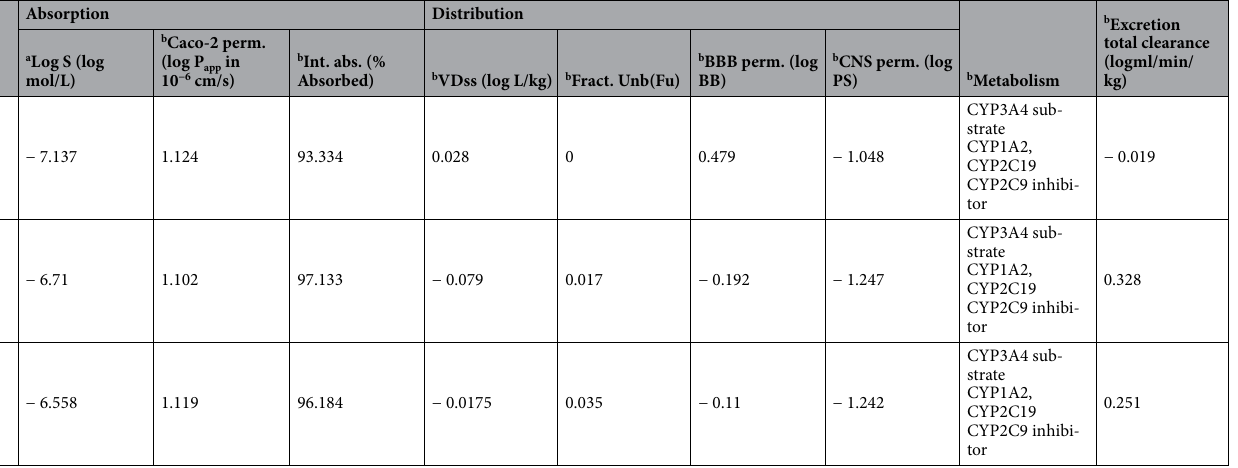
Table 3. ADME properties of benzyloxy chalcones [ B1–B15 ]. The pharmacokinetic properties were calculated in silico using online databases. a SwissADME (http:// www. swiss adme. ch/). b pkCSM (http:// biosig. unime lb. edu. au/ pkcsm/). Molecules with Log BB > 0.3 are considered readily to cross the BBB, while molecules with logBB < − 1 are poorly distributed to the brain. Compounds with log PS > − 2 are considered to penetrate the CNS, while those logPS < − 3 are considered unable to penetrate the CNS. perm.,